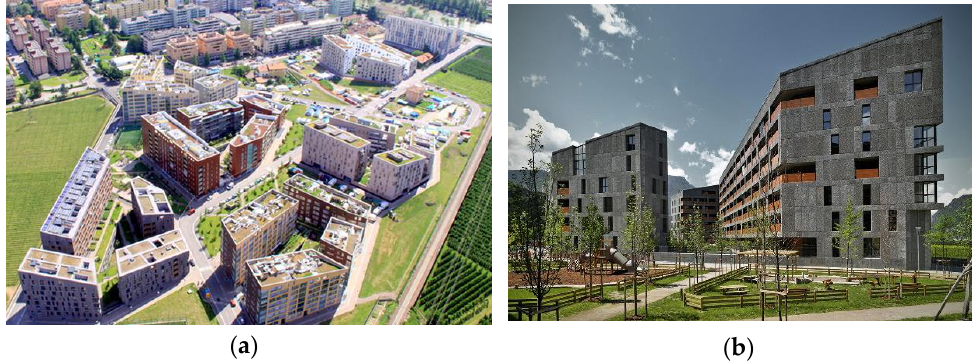
Figure 14. ( a ) Aerial view of CasaNova district showcasing the buildings’ arrangement around courtyards to form urban blocks (source: © altoadige.it); ( b ) view of the block designed by CDM Architetti Associati in the north part of the plot (photo: © Andrea Martiradonna).